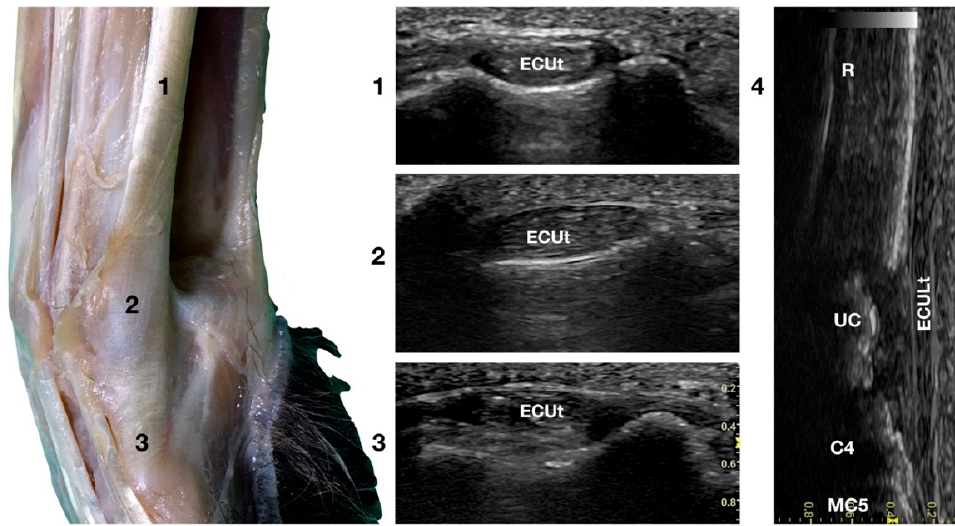
Figure 5. Lateral carpal face centred on the Extensor Carpi Ulnaris tendon. At the ulnar notch level (2), the ECUt is seen as a wide and flattened oval tendon in direct contact with the osseous surface. Proximally (1), the tendon is thick and narrow. The ECUt runs on the lateral face of the carpus and ends at the base of the fifth metacarpal bone where it reaches its maximum width (3). On the longitudinal scan plane (4), the prominent fibrillar pattern of the large tendon is visible. The osseous surface beneath is recognisable. R, radius; RC, radiocarpal bone; C4, fourth carpal bone; MC5, fifth metacarpal bone.